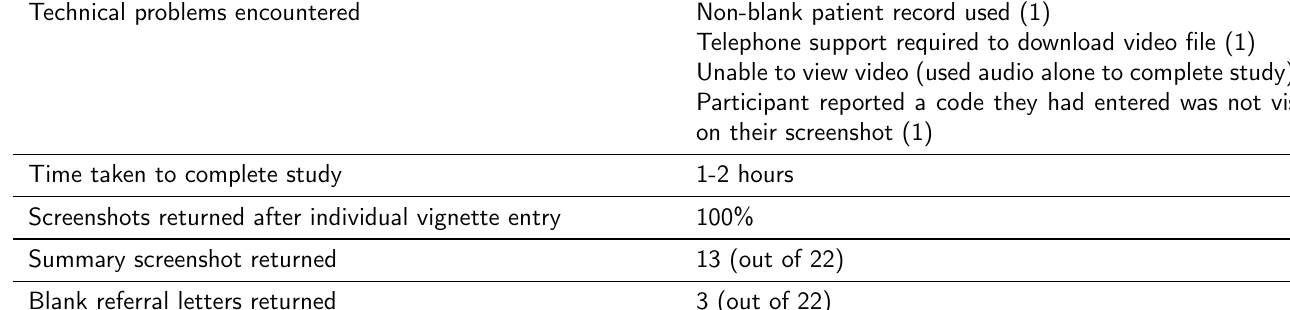
Table 3: Technical Feasibility